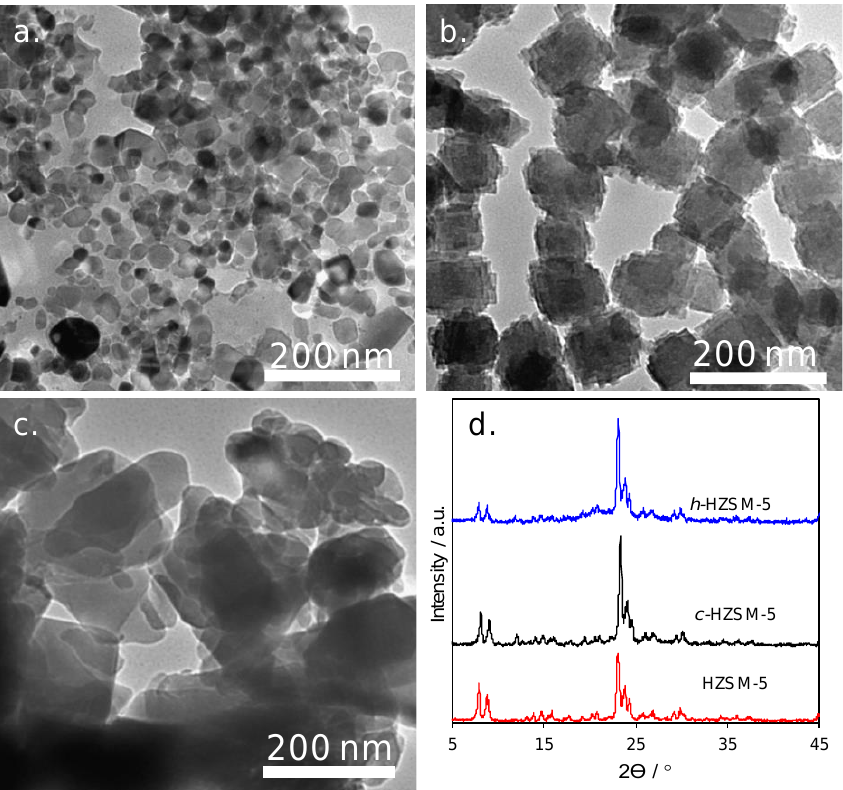
Figure 2. HR-TEMimages of uncalcined ( a ) h-HZSM-5, ( b ) c-HZSM-5, and ( c ) HZSM-5, and ( d ) powder x-ray diffraction (XRD) patterns for the three zeolites.